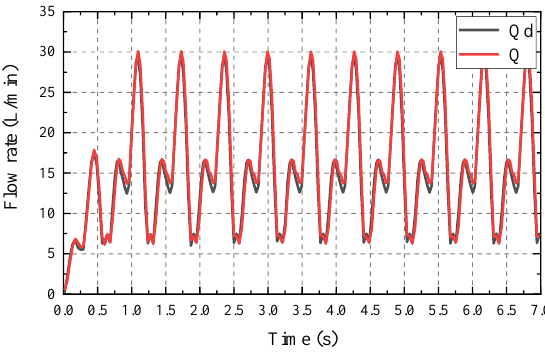
Figure 18. The total flow rate of the HHR.